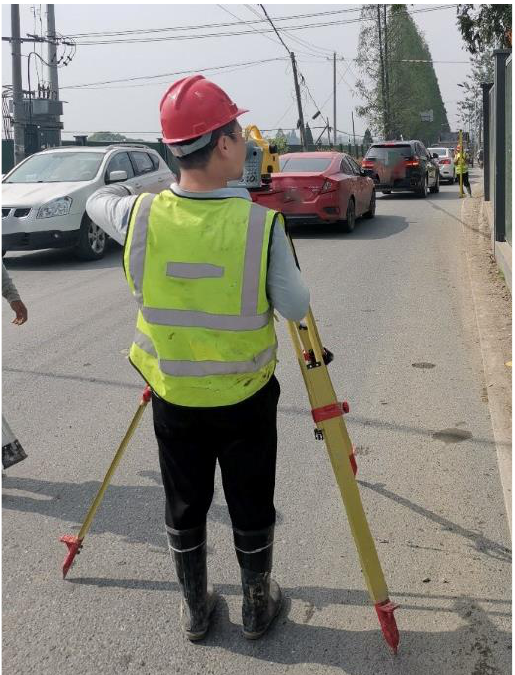
Figure 5. Construction monitors were measuring settlements of observation points.